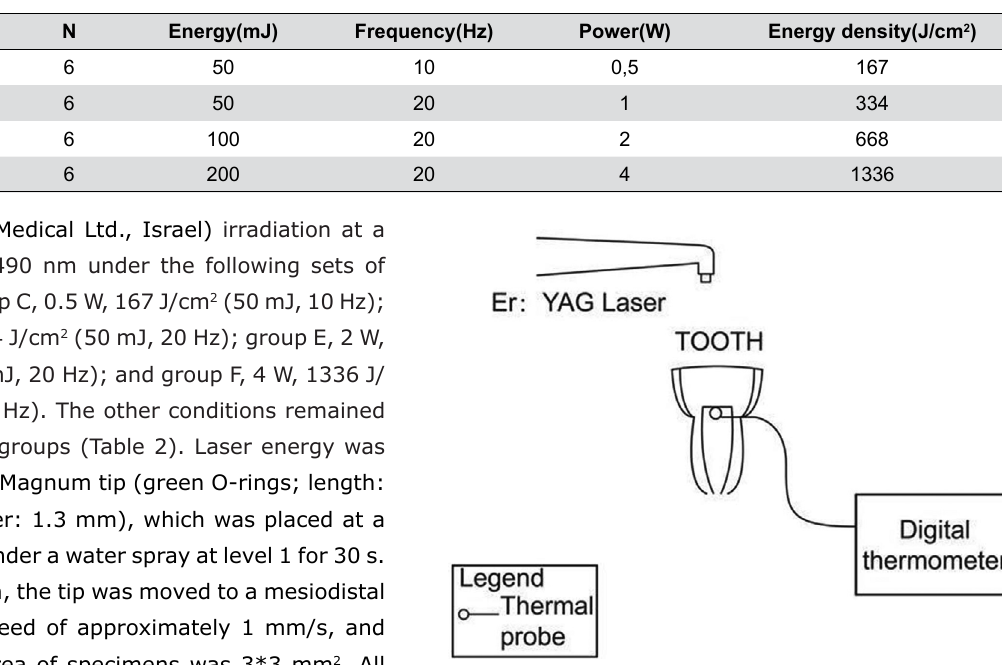
Table 2- Parameters of Laser Groups